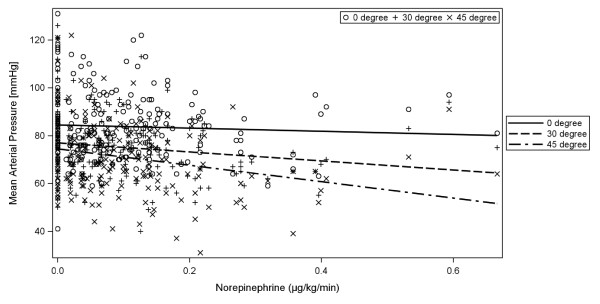
Effect or norepinephrine on mean arterial pressure; P = 0.012. Despite the high variability, there is an clear tendence to lower MAP by higher dose of norepinephrine. This effect is significantly stronger in the 45° position then in the full horizontal position; norepinephrine and its interaction with HBE, P = 0.005. HBE: head of bed elevation; MAP: mean arterial pressure.